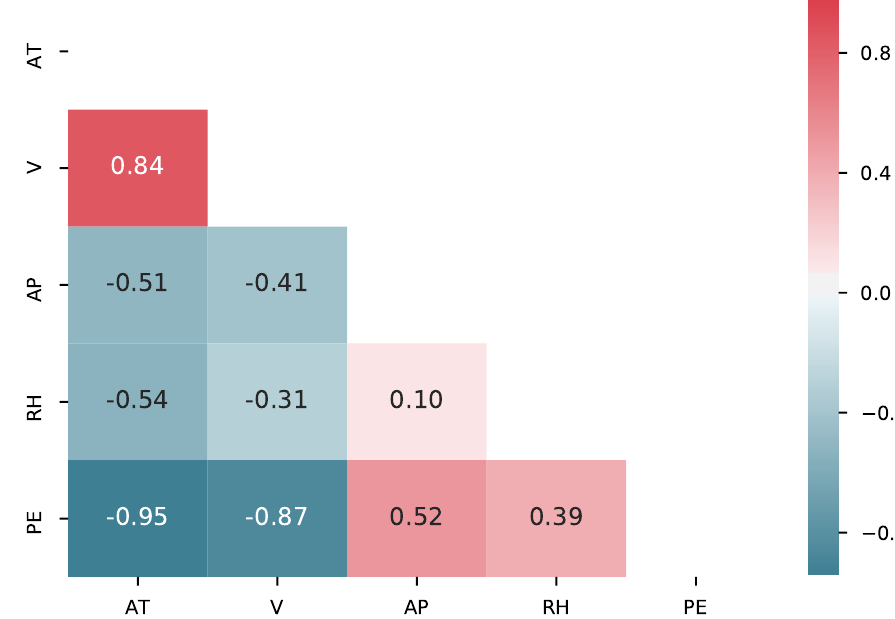
Figure 7. Heat map for visualizing the correlation between features.